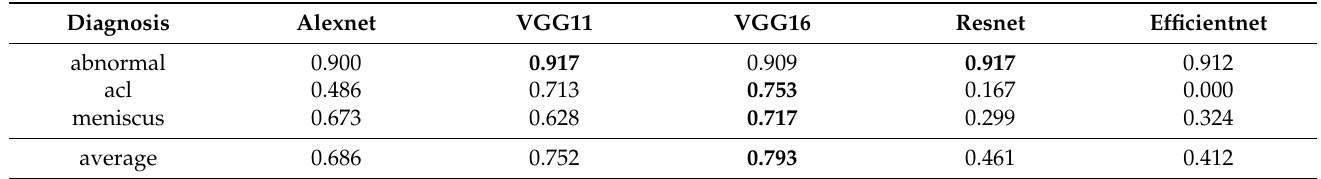
Table 3. F1-Score evaluation per model, per diagnosis (threshold = 0.5). Maximum values are highlighted in